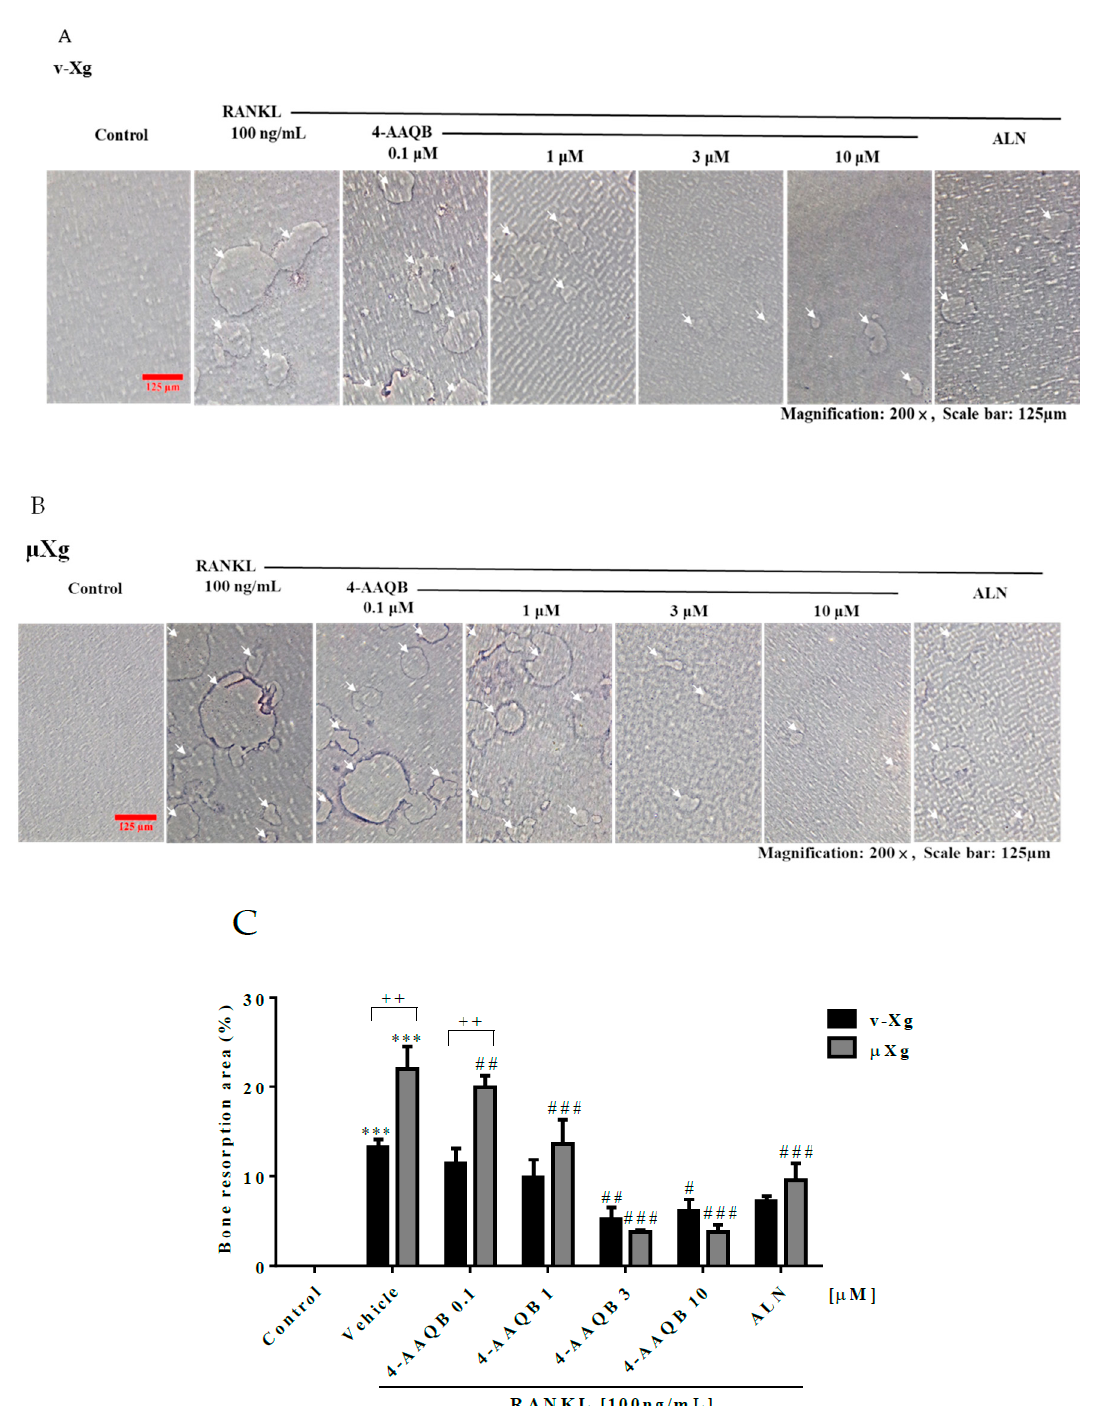
Figure 3. 4-AAQB attenuation of osteoclast resorption ability after v-Xg and µ Xg stimulation. After exposure in v-Xg ( A ) or µ Xg ( B ) for 24 h, and the cells were cultured in osteo assay 96-well plates and treated with 4-AAQB (0.1, 1, 3, or 10 µ M) or ALN (10 µ M) combined with RANKL for 120 h. The bone resorption area (%) ( C ) quantitative results represent the mean ± SEM (n = 4). White arrows indicate the resorption pits. *** p < 0.001 versus control; # p < 0.05, ## p < 0.01, and ### p < 0.001 versus RANKL; ++ p < 0.01 versus v-Xg.